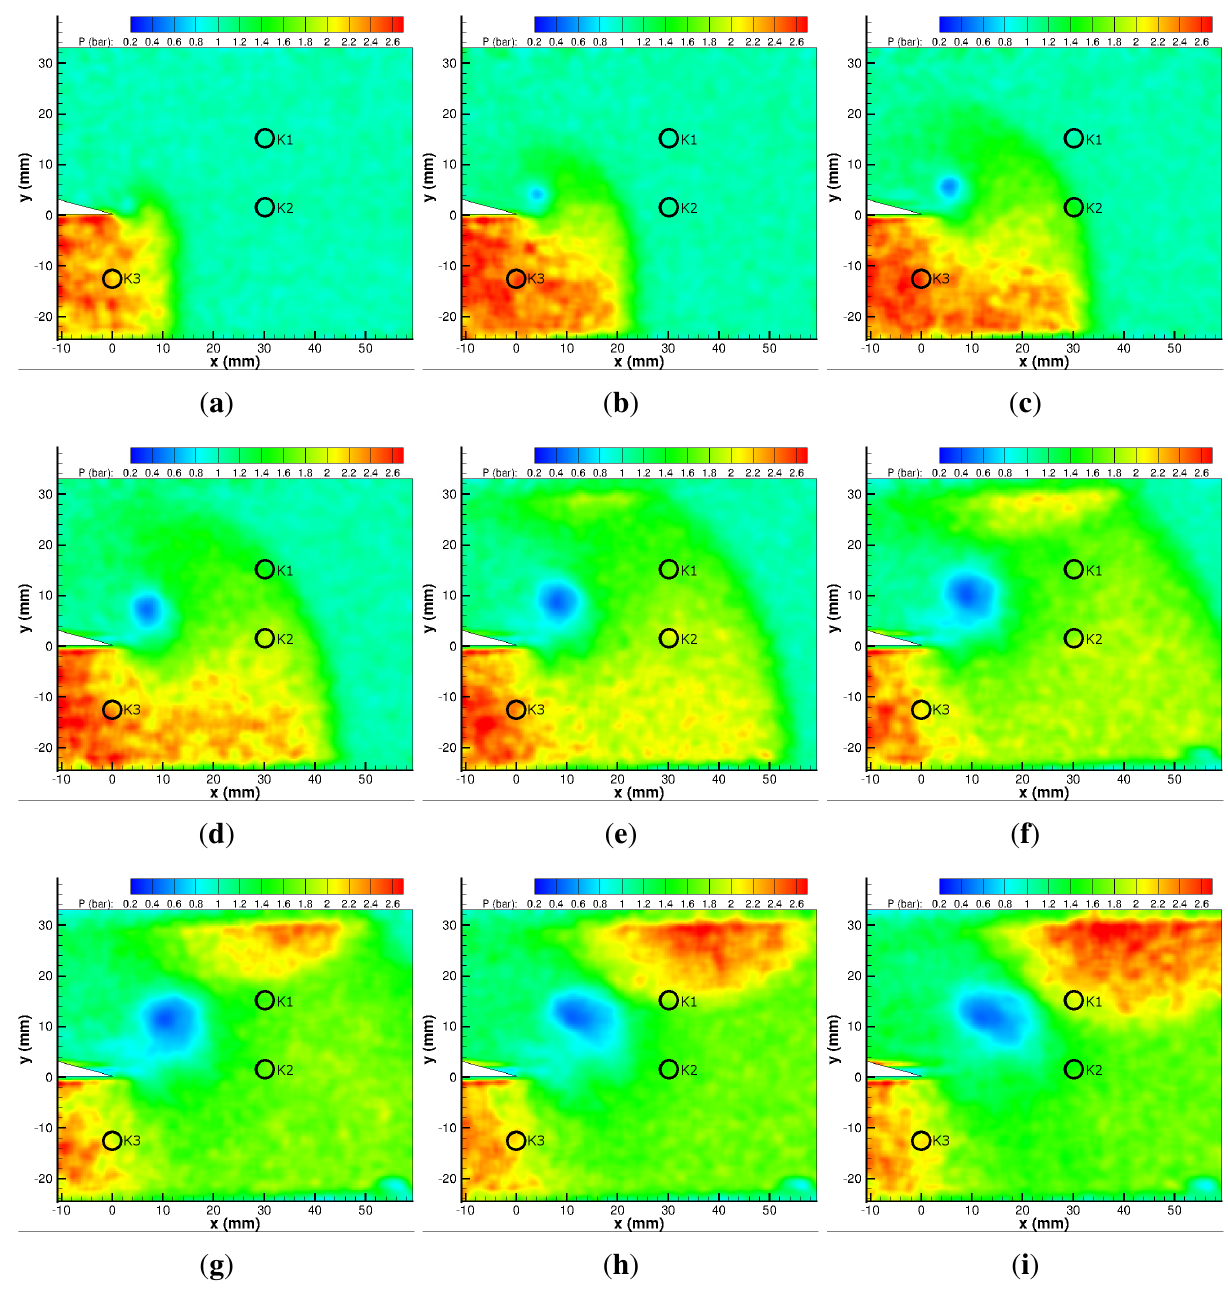
Figure 13. PSP map of M = 1 . 55 shock diffraction process. ( a ) 20 µ s; ( b ) 40 µ s; ( c ) 60 µ i